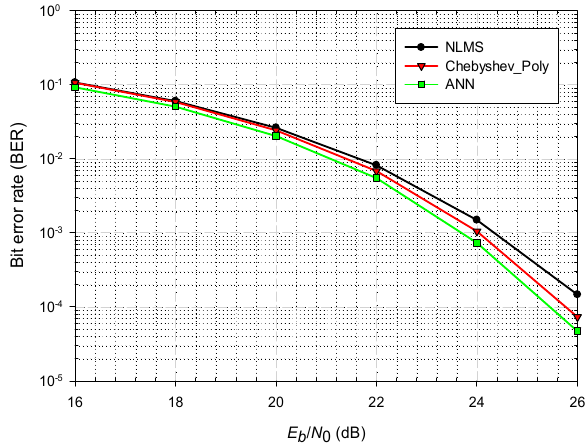
Figure 9. BER in AWGN versus 𝐸 (cid:3029) /𝑁 (cid:2868) for the NLMS, the Chebyshev polynomial, and the pro- posed ANN predistortion with 16 QAM.